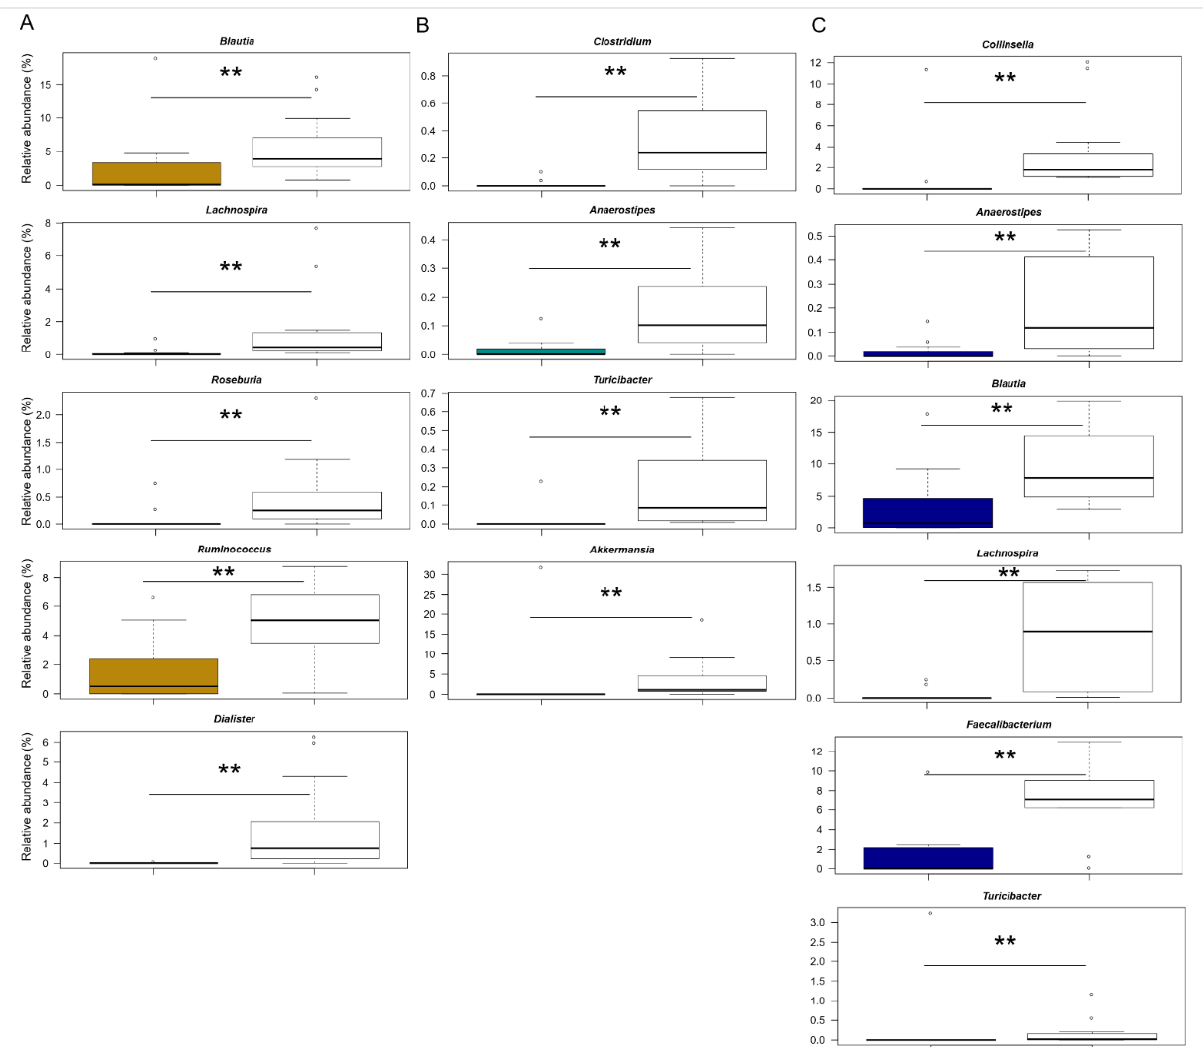
Figure 2. Compositional differences in the gut microbiota of patients with Kawasaki disease, Henoch – Schönlein purpura and non-KD febrile illness vs. healthy children. Boxplots showing the relative abundance distribution of bacterial genera significantly differentially represented between each patient group (( A ) Kawasaki disease; ( B ) Henoch–Schönlein purpura; ( C ) non-KD febrile illness) and their respective controls, carefully matched by age and sex (same colour code as in Figure 1). Only taxa with relative abundance >0.1% in at least 3 samples are shown; ** for p < 0.01, Wilcoxon test. Interestingly, in this cohort, IgA levels correlated positively with the relative abun- dance of Bifidobacterium (tau = 0.556, p = 0.04; Kendall rank correlation test) but negatively with that of Klebsiella (tau = − 0.645, p = 0.03). Other significant inverse correlations were observed between calprotectin levels and proportions of unclassified genera of Rikenel- laceae , as well as between IL12p70 and IL10 with Blautia and between TNF-alpha and Christensenellaceae _unclassified and Butyricimonas (tau ≤ − 0.53, p ≤ 0.05). Christensenel- laceae _unclassified also tended to correlate negatively with calprotectin (tau = − 0.546, p = 0.06), but positively with IgG (tau = 0.546, p = 0.06). IgG levels tended to correlate positively with Bifidobacterium (tau = 0.5, p = 0.08) as well, but negatively with Klebsiella (tau = − 0.559, p = 0.06). Other noteworthy trends included a direct correlation of TNF-alpha with Eubacterium (tau = 0.471, p = 0.09), and a negative one with Coprococcus and Prevotella (tau = − 0.497 and − 0.524, respectively; p = 0.08). Unclassified genera of Lachnospiraceae tended to correlate positively with IgA (tau = 0.5, p = 0.08) and IL10 (tau = 0.479, p =